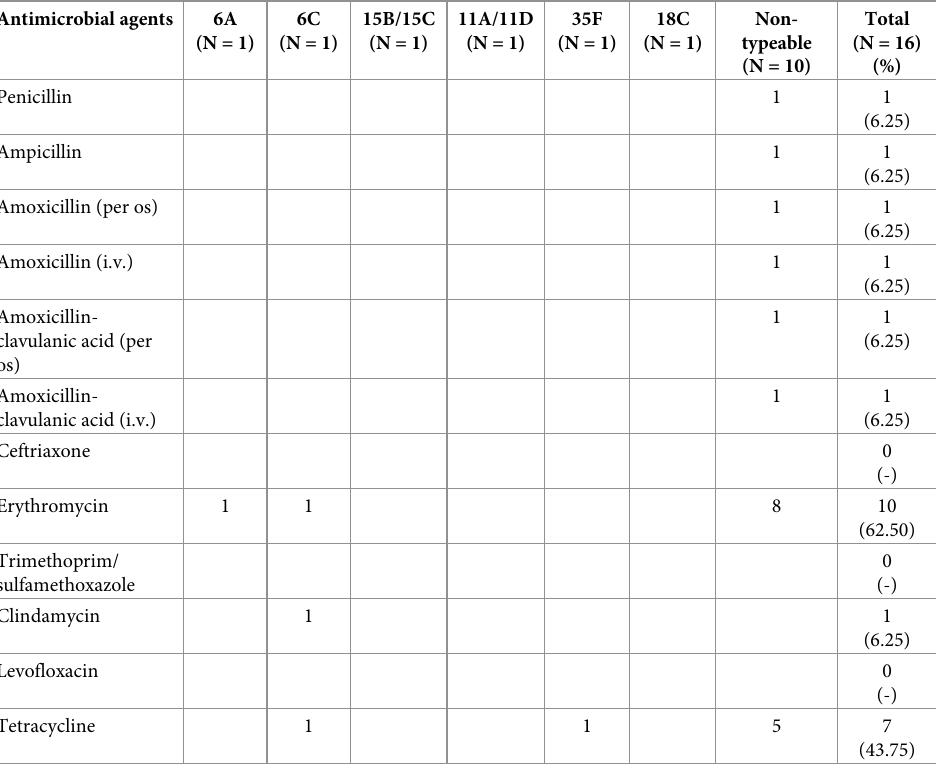
Table 4. Resistance patterns of Streptococcus pneumoniae